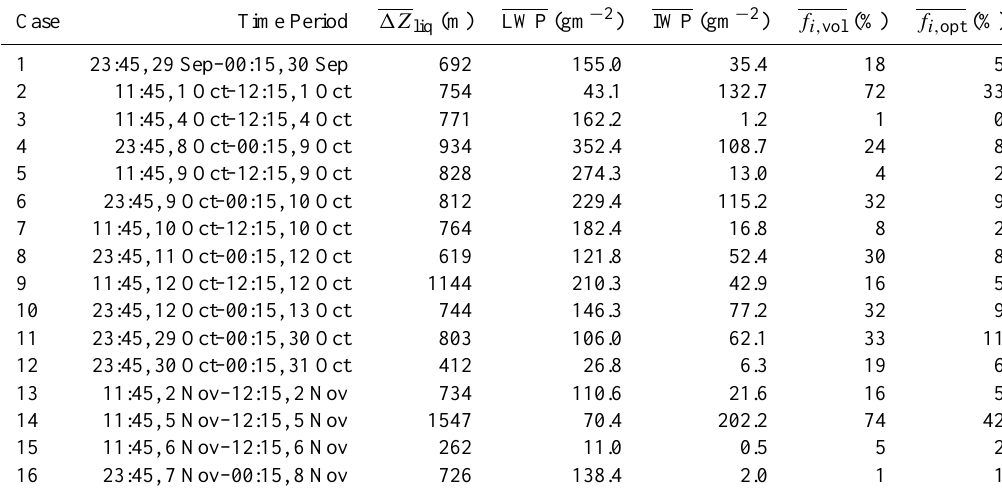
Table 1. Case overview providing case numbers, the time periods covered, and values for case mean liquid cloud depth, case mean liquid water path and case mean ice water